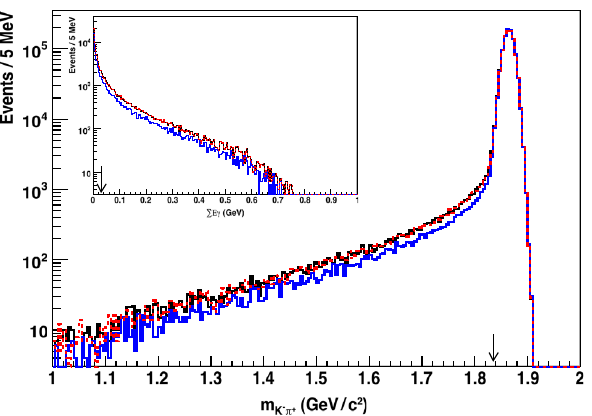
Fig. 209 The K π invariant mass distribution for D 0 → K − π + ( n γ) decays. The three curves correspond to three different configurations of PHOTOS for modeling FSR: version 2.02 without interference ( blue / grey ),version2.02withinterference( reddashed )andversion2.15 withinterference( black ).Thetrueinvariantmasshasbeensmearedwith a typical experimental resolution of 10 MeV / c 2 . Inset The correspond- ing spectrum of total energy radiated per event. The arrow indicates (cid:10) E γ value that begins to shift kinematic quantities outside of the the range typically accepted in a